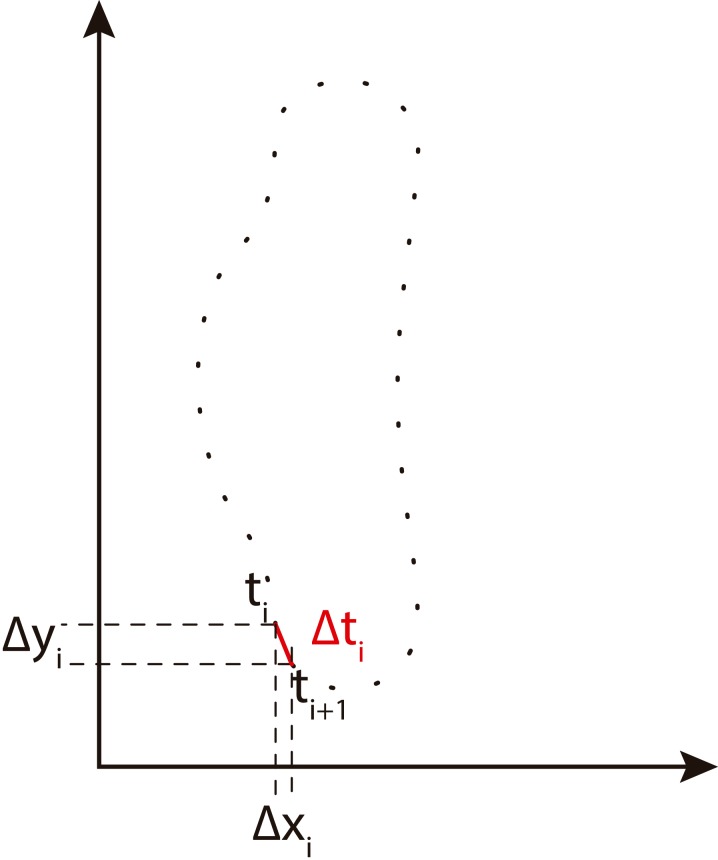
Freeman chain code projections used to calculate Fourier descriptors (adapted from Tort, 2003).